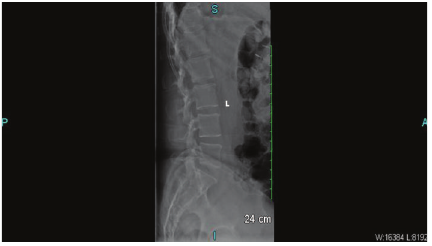
Figure 1: Plain lumbosacral X-ray showing degenerative changes.